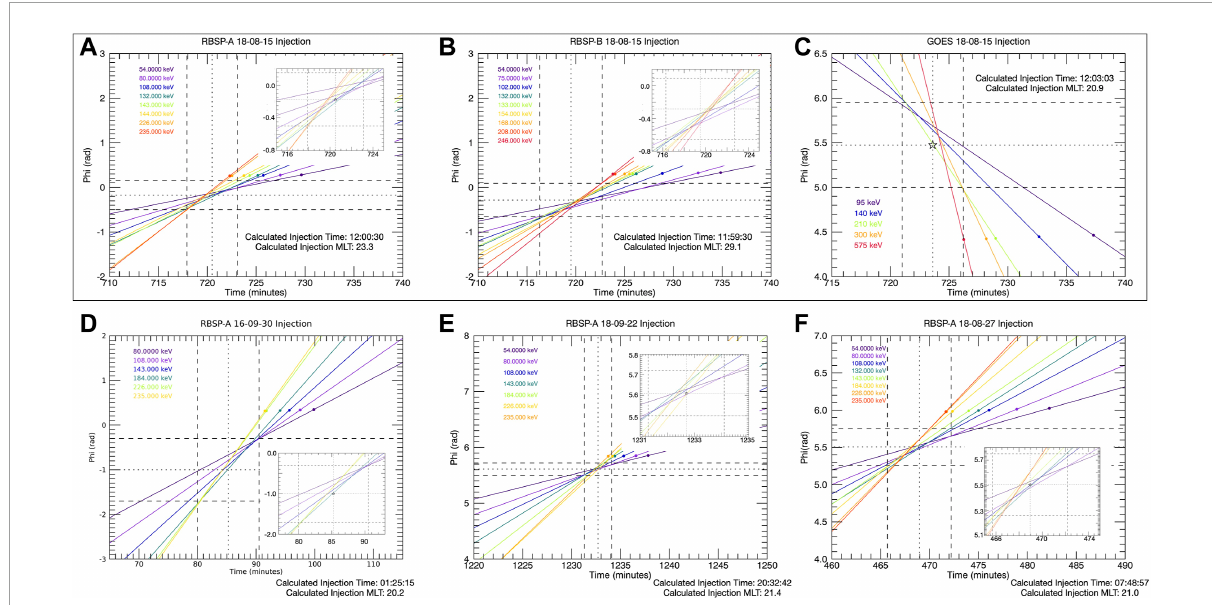
FIGURE 5 Plots to find the injection location of each dispersed electron injection at Van Allen Probes and the ion injection at GOES. The dots are the time and location of the injection at each energy, and the lines are determined by Eq. 1 . The inset of each graph shows the intersection of the lines, with the dashed lines being upper and lower bounds for the injection location, which is estimated to be the at the center of the upper and lower bounds by the star. The top row is the 15 August 2018 event at both Van Allen Probes and GOES, and the bottom row is all of the other events at just RBSP-A.